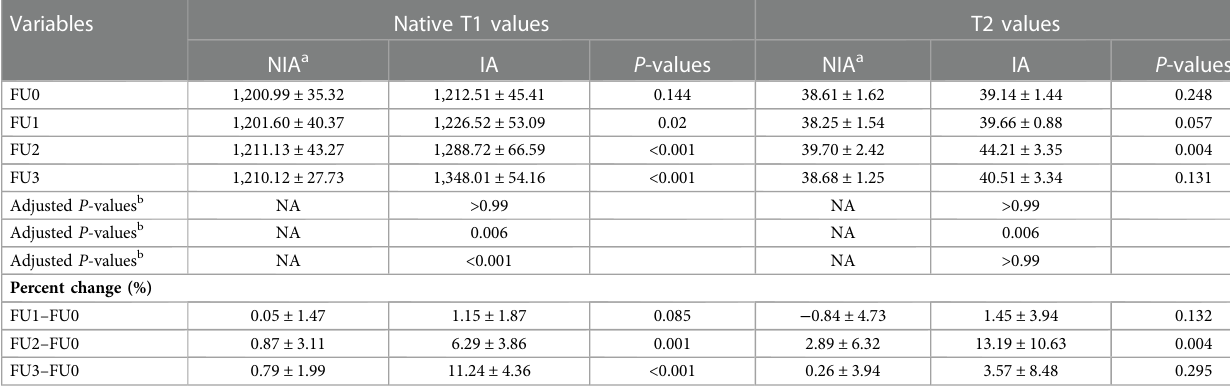
TABLE 4 Native T1 values, T2 values, and their temporal percent changes at baseline and follow-ups.